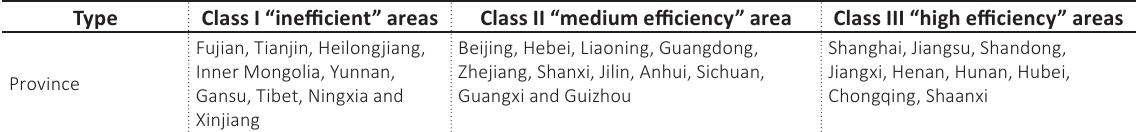
Table 2. Types of government funding performance in higher education in China Type